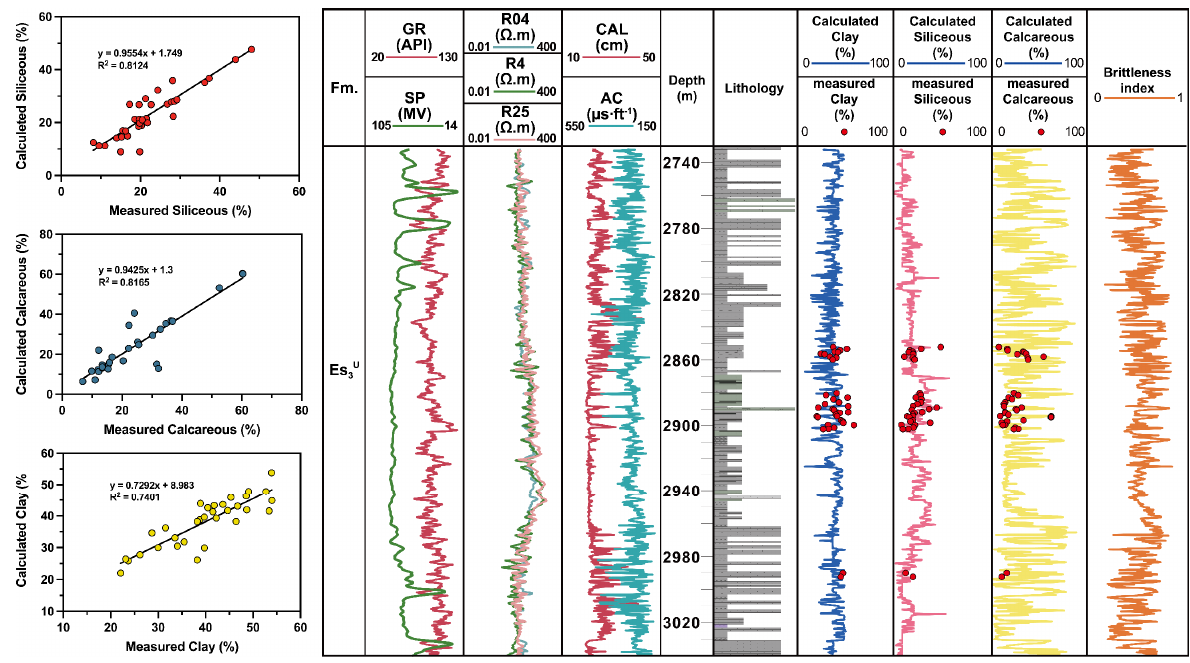
Figure 9. Calculated results of inorganic components and brittleness.